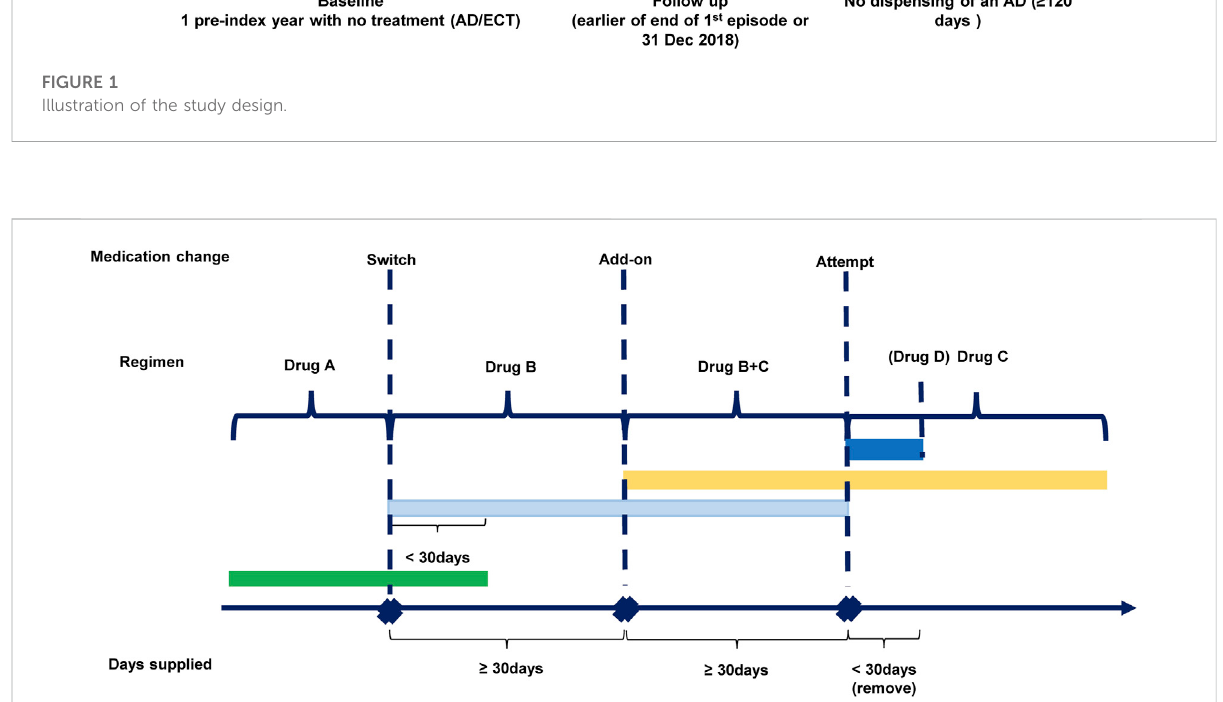
FIGURE 2 De fi ning different patterns of medication